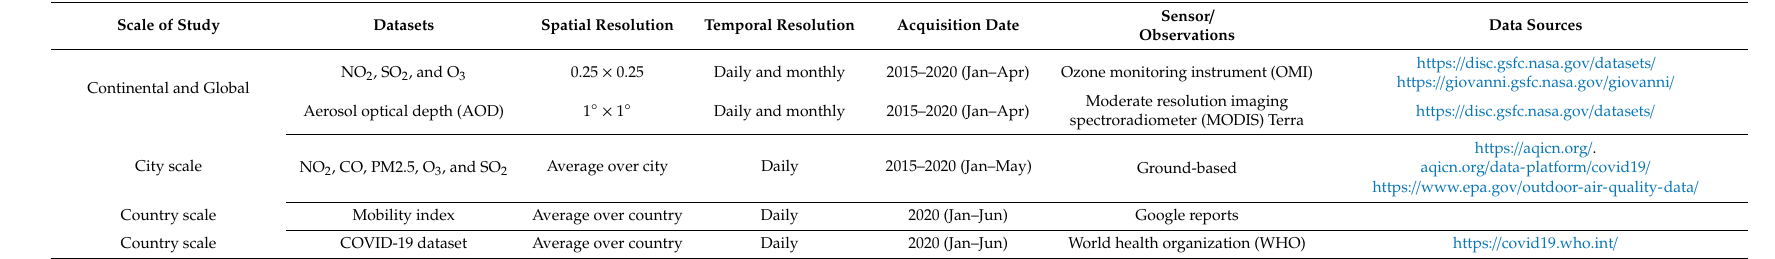
Table 1. Detailed description of the data used in this